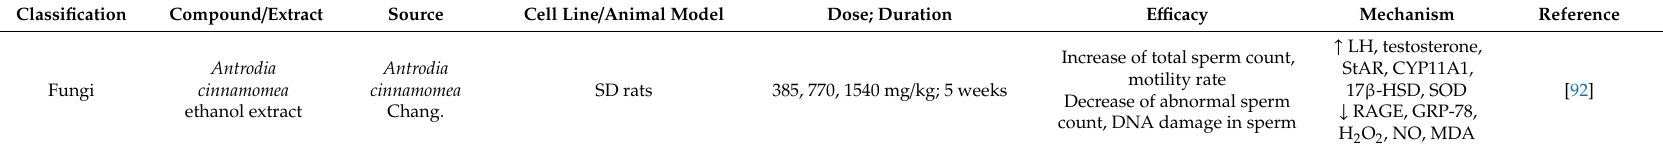
Table 5. Fungus derived natural product and male